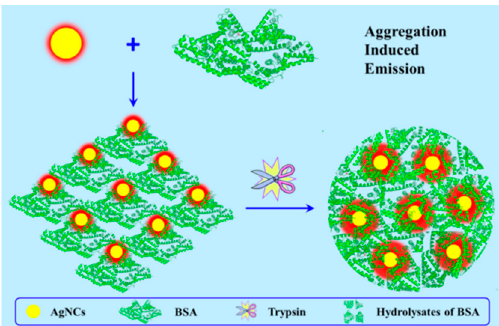
Figure 5. Schematic representation of the response self-assembly of dsDNA-Ag NCs to bovine serum albumin (BSA) and trypsin. Adapted with permission from Ref. [44]. Copyright (2017) Elsevier.